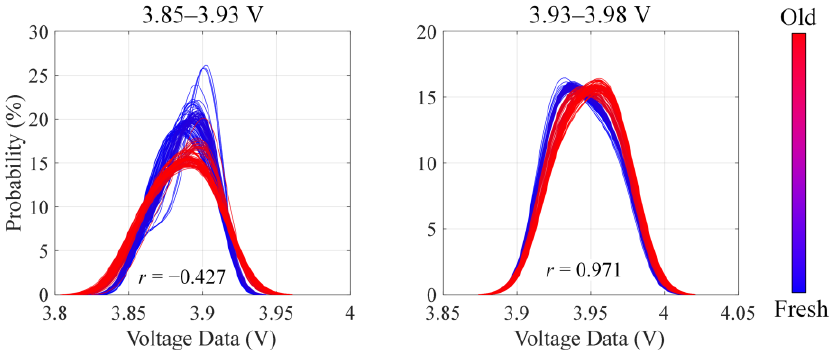
Figure 8. Examples of voltage data distribution in different sections.